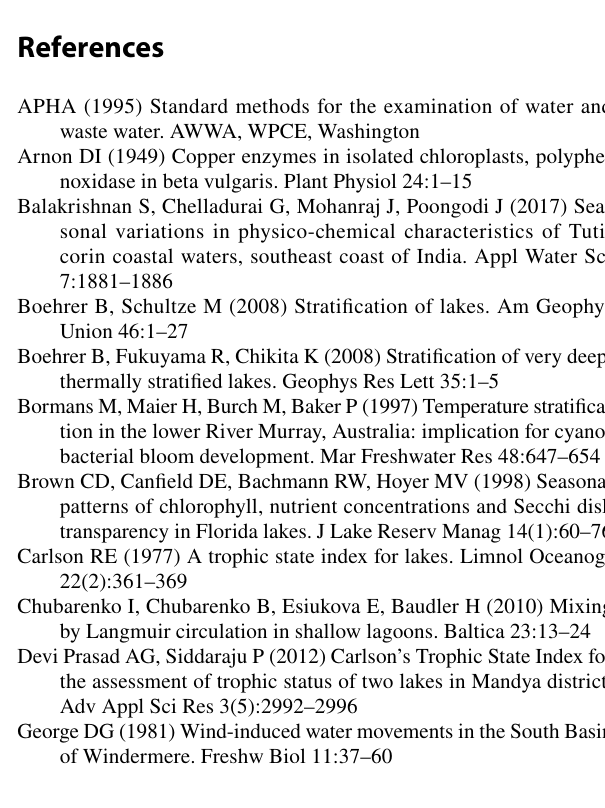
Fig. 2 Thermal (temperature—°C) and chemical (DO—mg/l) stratification in DTU pond during the